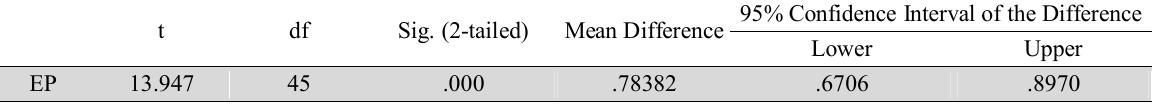
The summary of testing the effect of information technology on execution policy (Test value = 3) 95% Confidence Interval of the t df Sig. (2-tailed) Mean Difference